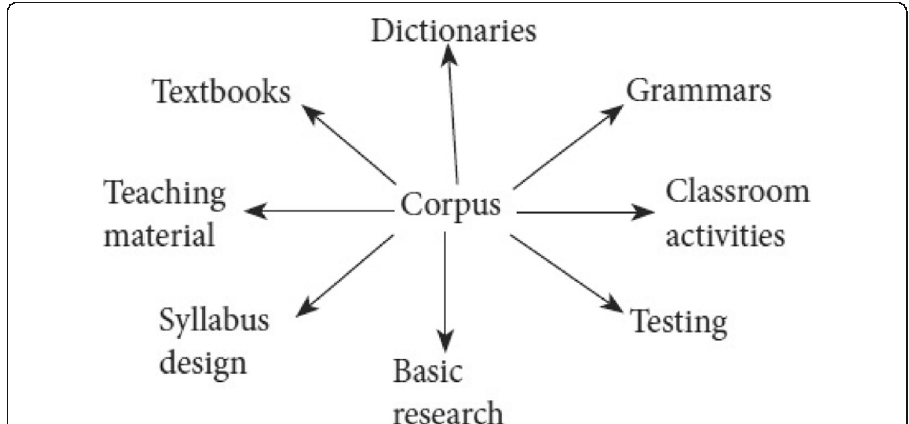
Fig. 1 Johansson: Uses of corpora of relevance for language